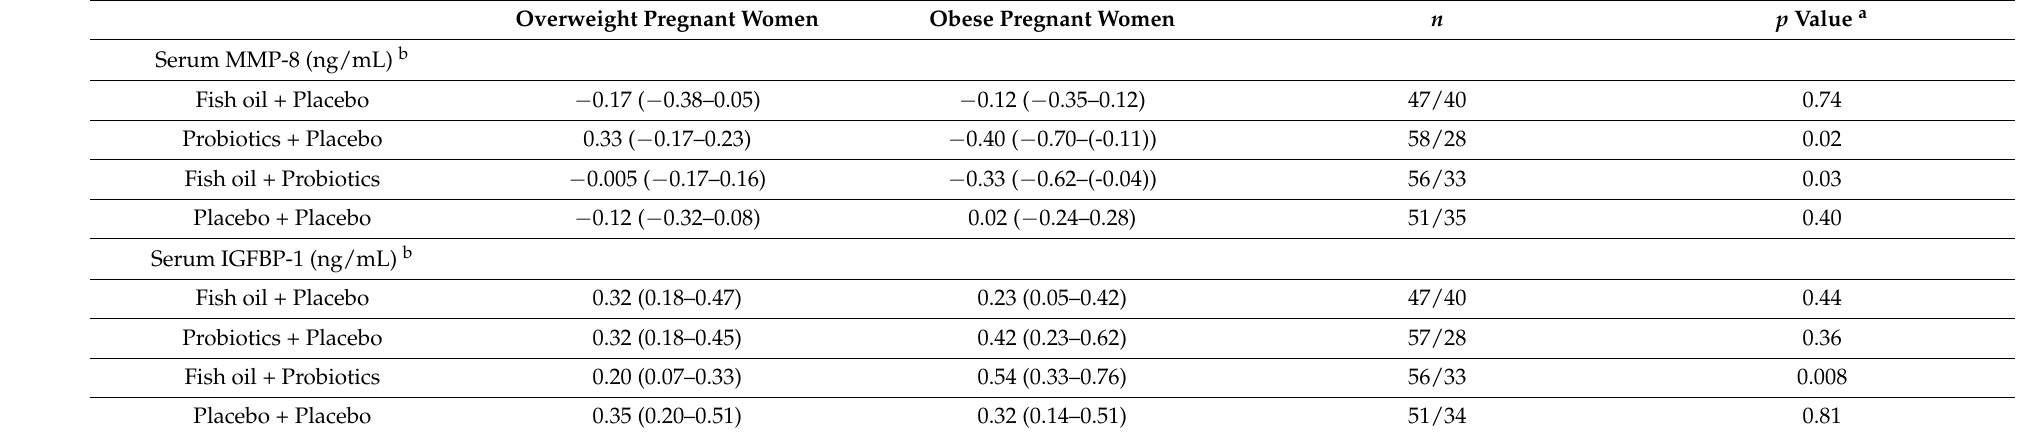
Table 2. The change in the serum levels of matrix metalloproteinase 8 (MMP-8) and insulin-like growth factor binding-protein 1 (IGFBP-1) (mean change (95%CI)) from early to late pregnancy in overweight and obese pregnant women subdivided according to the four intervention